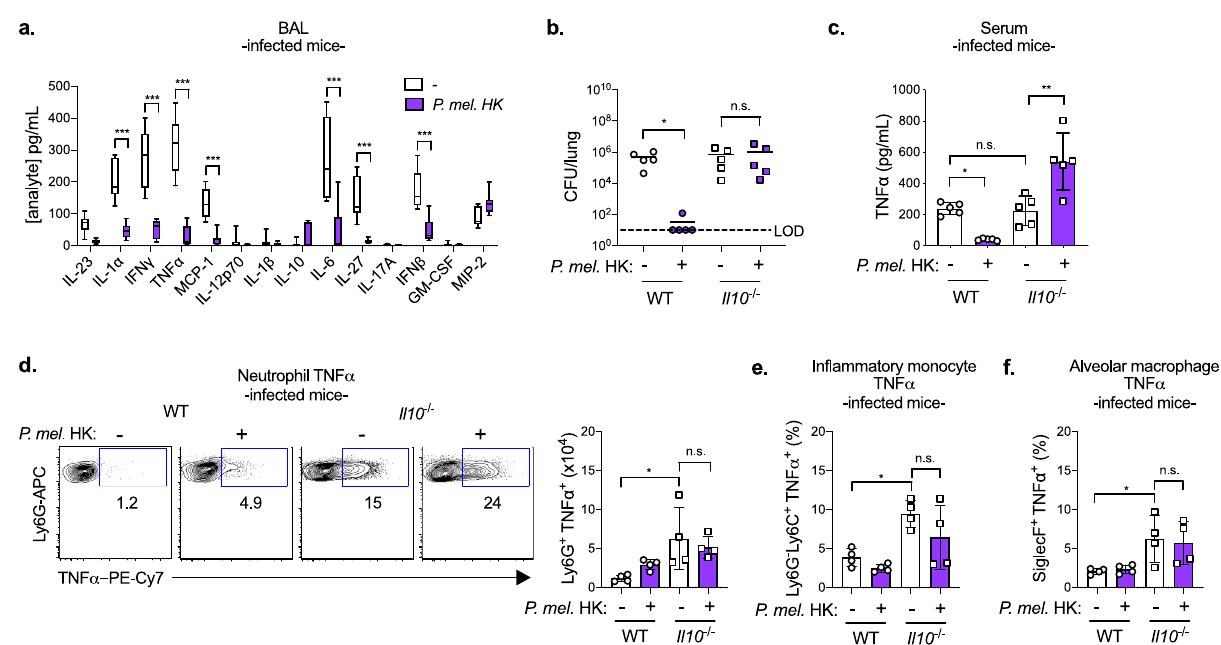
Fig. 8 P. melaninogenica ( P. mel .) - mediated protection against S. pneumoniae requires restraint of detrimental in fl ammation by IL-10. a Quanti fi cation of cytokines and chemokines in lung bronchoalveolar lavage (BAL) following exposure to PBS (-) or P. mel . strain 25845 heat-killed (HK) i.t. prior to 24 h type 2 S. pneumoniae infection, 5 × 10 6 CFU/mouse ( n = 9 mice/group). b , c Lung S. pneumoniae burdens ( b ) and serum TNF α ( c ) detected in WT or Il10 -/- mice exposed to either PBS (-) or P. mel . HK i.t. prior to 24 h S. pneumoniae infection ( n = 5 mice/group). d – f Representative fl ow cytometry plots and total cell numbers of neutrophil TNF α ( d ), percentage of in fl ammatory monocyte TNF α ( e ), and percentage of AM TNF α ( f ) detected by intracellular fl ow cytometry from WT or Il10 -/- mice treated with either PBS (-) or P. mel . HK i.t. prior to 24 h S. pneumoniae infection ( n = 4 mice/group). LOD = limit of detection. Data are pooled from three independent experiments ( a ) or representative from one of four independent experiments ( b – f ). Box boundaries in ( a ) indicate the 25th and 75th percentiles, with a horizontal line representing the median and whiskers indicating minimum and maximum values. Data in b – f are displayed as mean ± SEM. For a *** p < 0.0001, two-way ANOVA with Sidak ’ s post hoc test, b * p = 0.0257 (WT), p > 0.9999 ( Il10 -/- ), Kruskal – Wallis with Dunn ’ s post hoc test, c from left to right * p = 0.0393, p = 0.9973, ** p = 0.0012, one-way ANOVA with Tukey ’ s post hoc test, d from left to right * p = 0.0116, p = 0.7388, one-way ANOVA with Sidak ’ s post hoc test ( e ), from left to right * p = 0.0101, p = 0.1698, one-way ANOVA with Sidak ’ s post hoc test, f from left to right * p = 0.0280, p = 0.9298, one-way ANOVA with Sidak ’ s post hoc test. Source data are provided as a Source Data fi le.